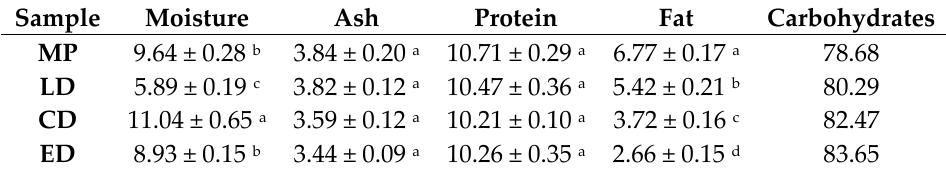
Table 1. Proximal composition of fresh puree and dry powders (g/100 g